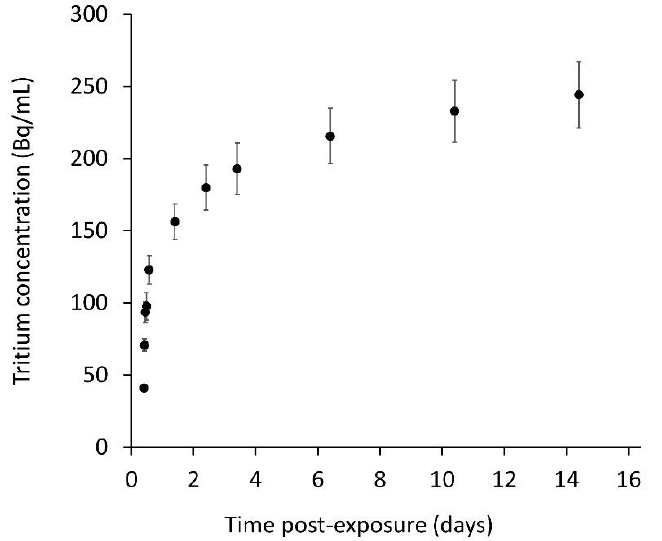
Figure 2. Release of tritium from tritiated steel particles: tritium concentration (Bq/mL) of lung lining fluid simulant (LLFS) samples.